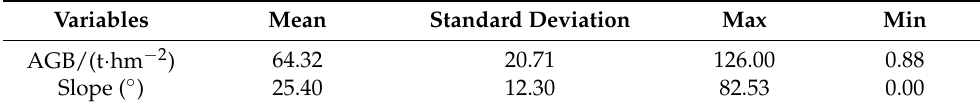
Figure 9. Variable distribution map. ( a ) AGB. ( b ) Slope. Table 5. Statistical characteristics of AGB and covariable.